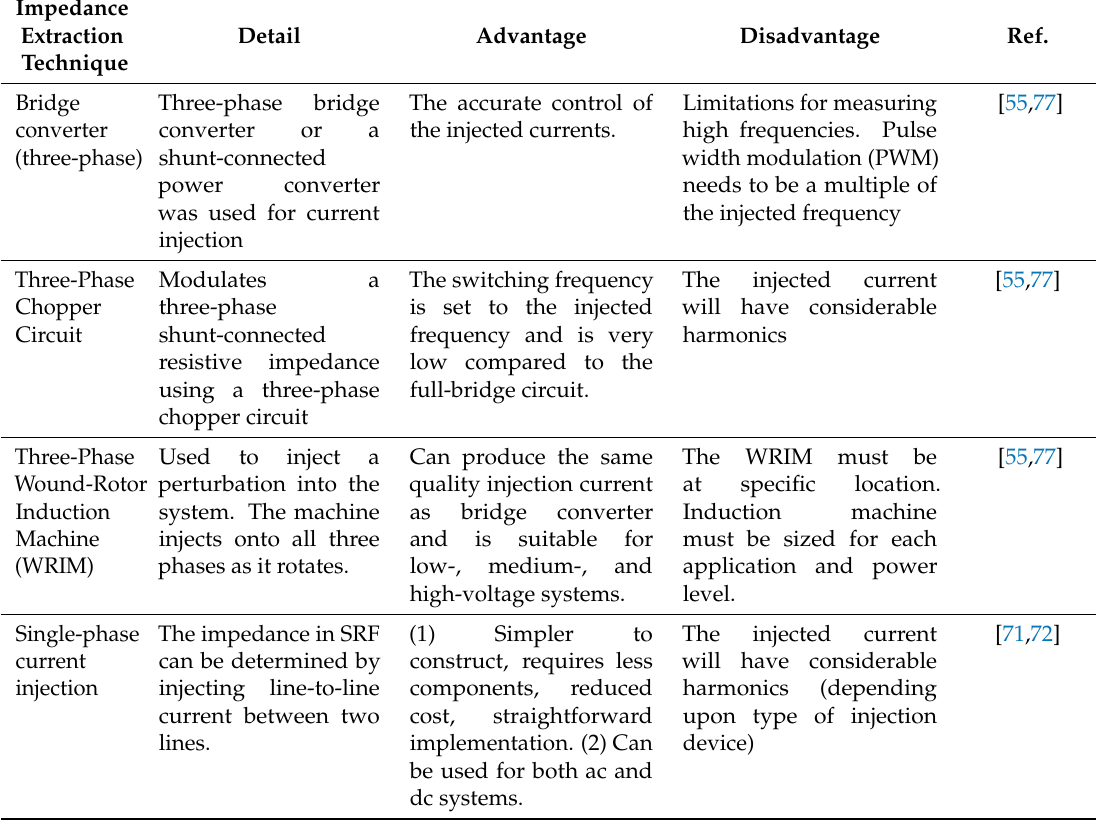
Table 3. Comparative Analysis of Different Shunt Current Impedance Extraction